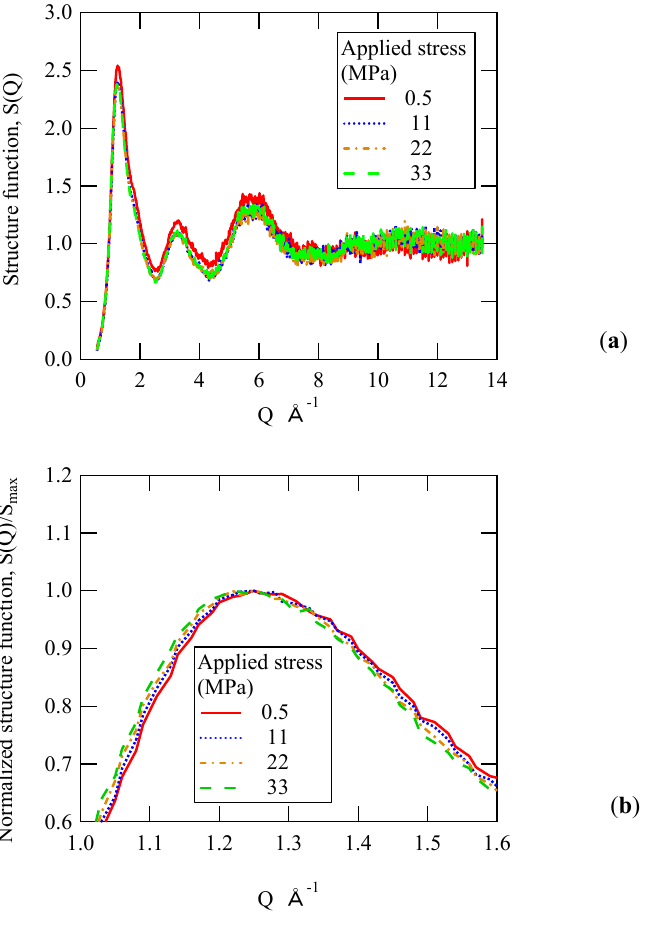
Figure 5. Change in structure function due to applied stress: ( a ) Wide range of profiles; ( b ) vicinity of the first peak of the normalized structure function.